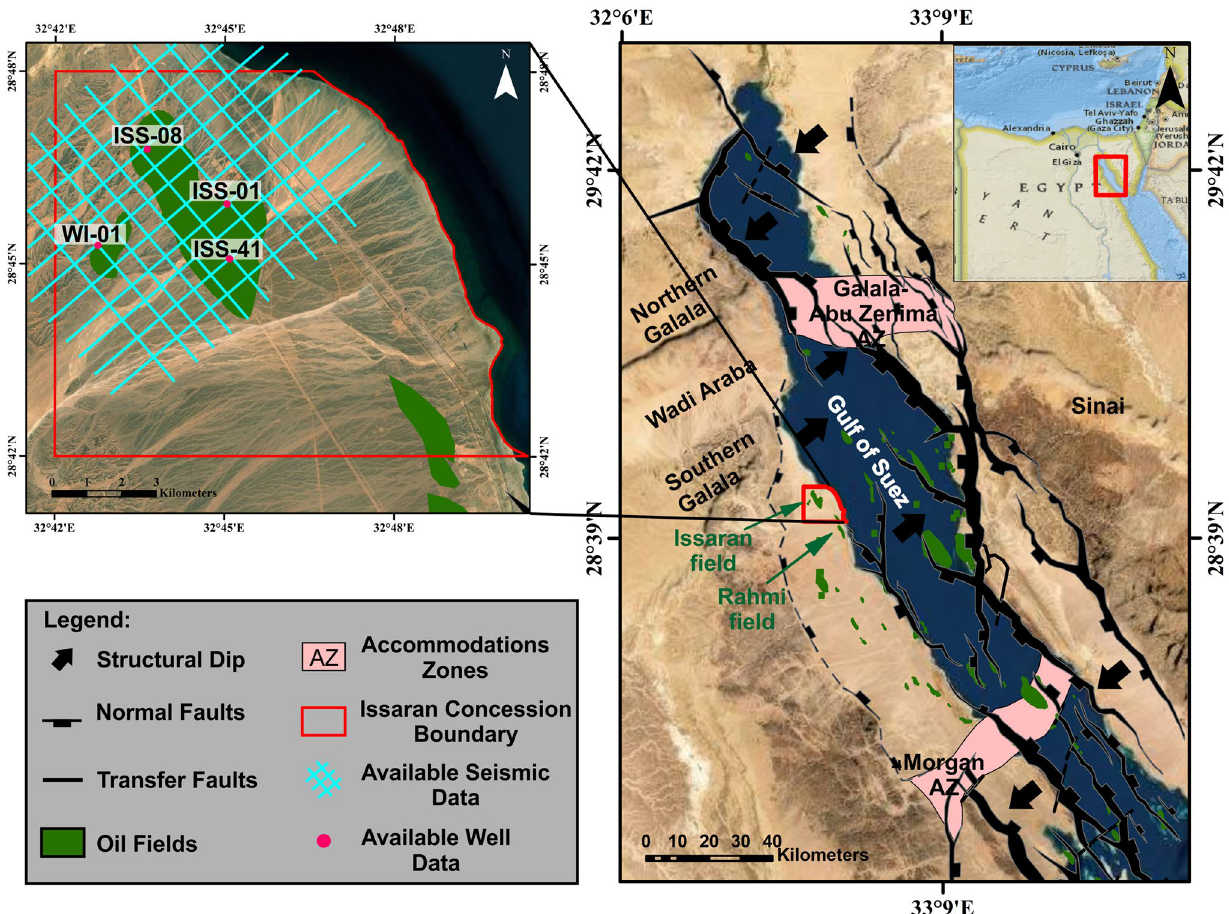
Fig. 1 A generalized structural map of the Gulf of Suez rift, after Bosworth et al. 2020, combined with the oil fields (Farhoud 2009), demonstrating the location of Issaran oil field. The black arrows show the dip directions of the three half grabens of the rift, and the faults